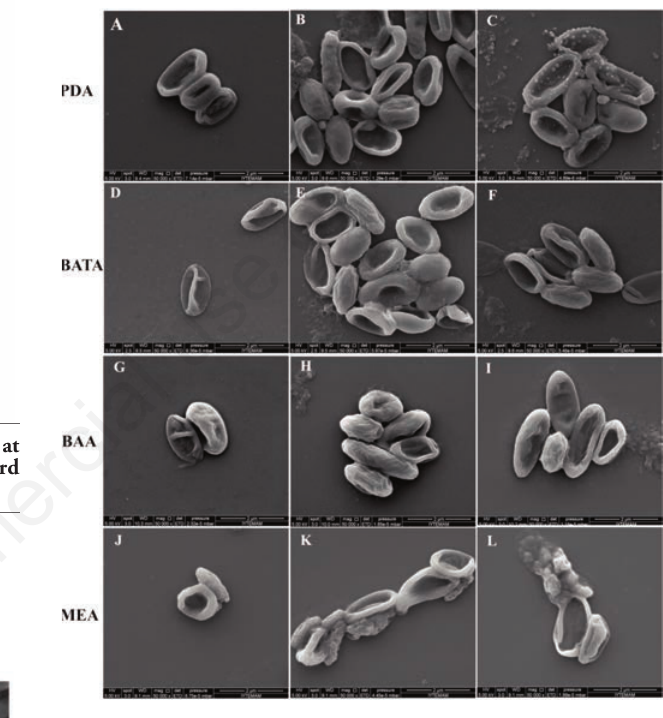
Figure 3. SEM images of A. acidoterrestris spores produced on PDA, BATA, BAA and MEA following wet-heat treatment for 15